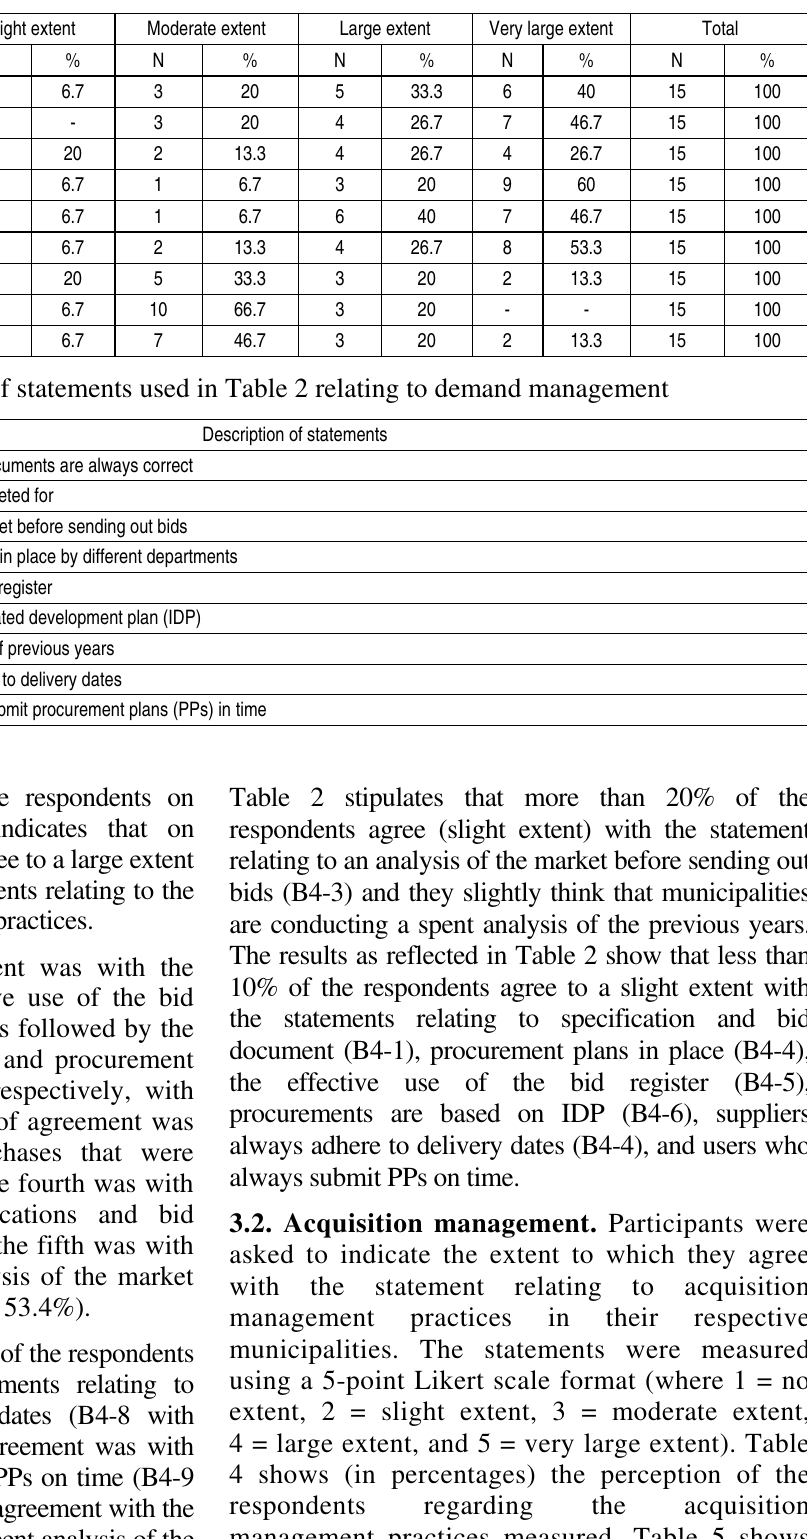
Table 2. Perception of respondents regarding demand management practices measured in percentages